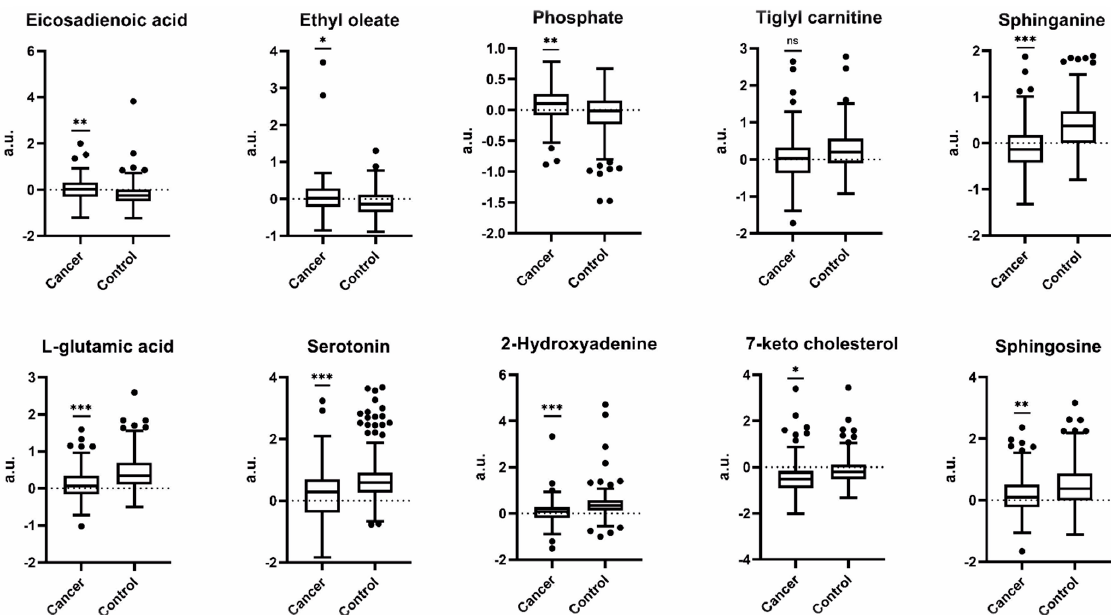
Figure 4. Box plots of peak areas for the 10 discriminants metabolites in participants who developed PCa during the follow-up and matched controls. Eicosadienoic acid, ethyl oleate, and phosphate were relatively higher in PCa group than in controls; on the contrary, L-glutamic acid, 2-hydroxyadenine, 7-keto cholesterol, tiglyl carnitine, serotonin, sphinganine, and sphingosine were relatively lower in PCa group than in controls. Sparse partial least squares discriminant analysis (sPLS-DA) was used to identify the top 10 most important metabolites discriminating PCa cases ( n = 146) from controls ( n = 272). Significance was determined by p-value with Bonferroni adjustment (Supplemental Table S2.): * p < 0.05; ** p < 0.01; *** p < 0.001; ns, not significant. The y-axis represents peak areas after removing variability in QC samples, probabilistic quotient normalized, centering, unit variance scaling, and generalized logarithm transformed. a.u.: arbitrary unit.